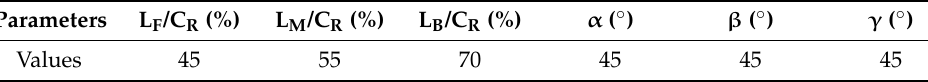
Figure 1. Geometric description of NASA Stage 37 compressor and RE2B: ( a ) Geometric parameters of RE2B; ( b ) meridional view of NASA Stage 37 with RE2B. Table 1. Reference design of RE2B.